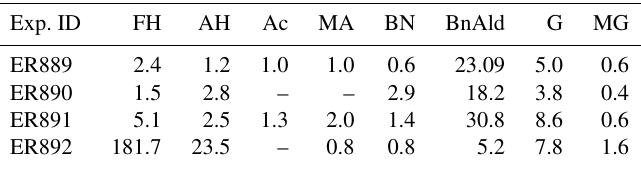
Table 4. Steady-state carbonyl concentrations (ppmV) during BnOH oxidation (FH: formaldehyde; AH: acetaldehyde; Ac: acetone; MA: methacrolein; BN: 2-butanone; BnAld: benzaldehyde; G: glyoxal; MG: methylglyoxal). Exp. ID FH